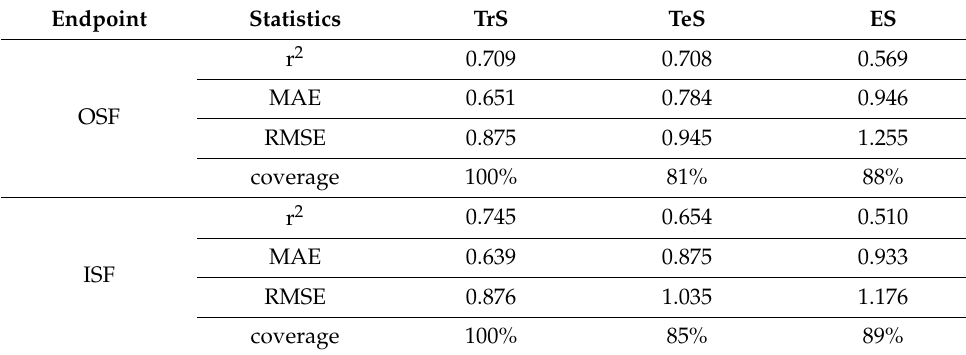
Table 2. Performance of OSF and ISF regression models derived with split scheme A.